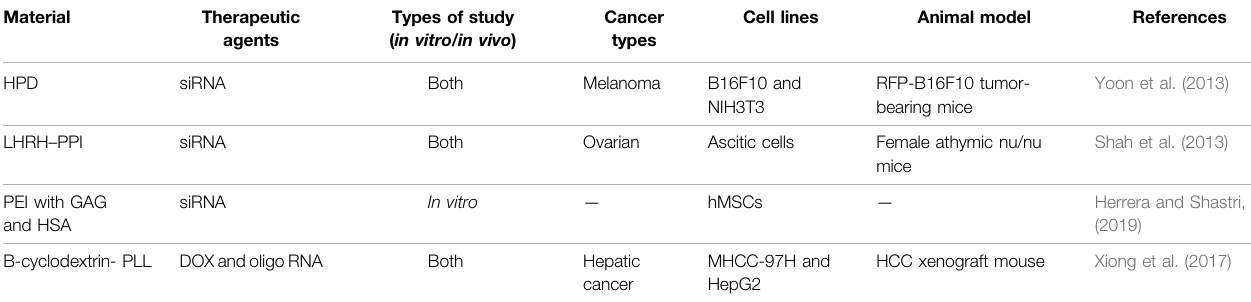
TABLE 9 | Examples of siRNA-based CD44-mediated